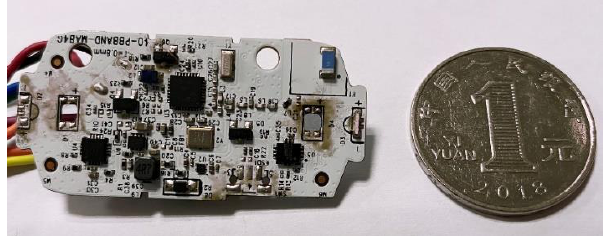
Figure 11. Implemented circuit board and size comparison with a coin.